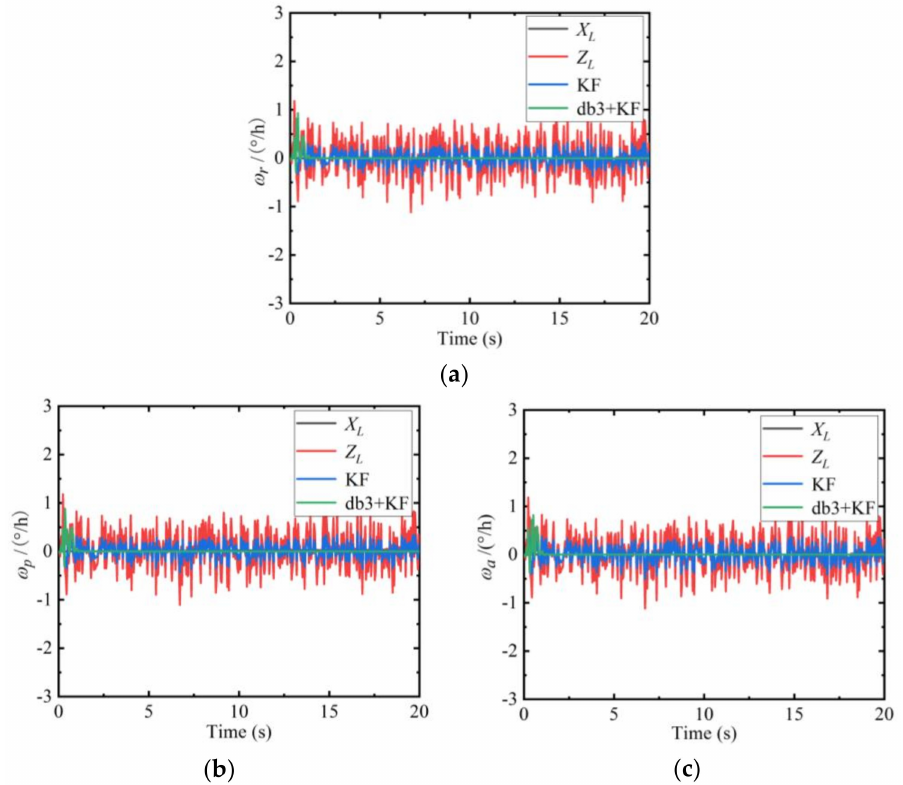
Figure 3. Comparison of angular velocity filtering results of the inertial navigation systems